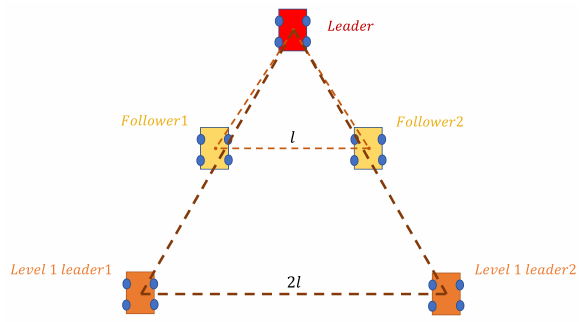
Figure 16. The double-layer triangle formation for